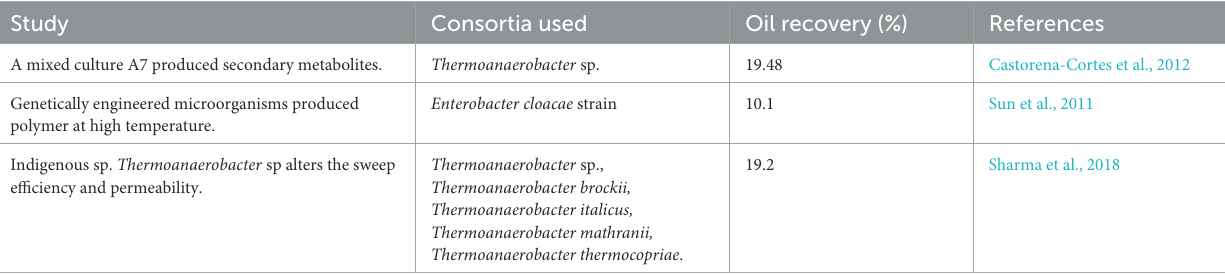
TABLE 4 Percentage of oil recovery previously